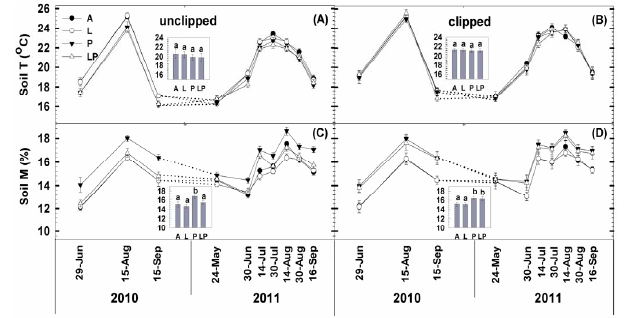
Fig. 2. Seasonal variations of soil temperature ( T ) and soil moisture (M) at 10cm depth in response to belowground particulate litter ad- dition ( + 60%), increased precipitation ( + 30%) and clipping dur- ing the two growing seasons in the temperate steppe of northeast- ern China (Fig. 2A, C from Ma et al., 2012). Insets represent the two seasonal mean values of soil temperature and moisture. Verti- cal bars indicate standard error of means ( n = 6). Different lower- case letters indicate statistically significant differences ( P <